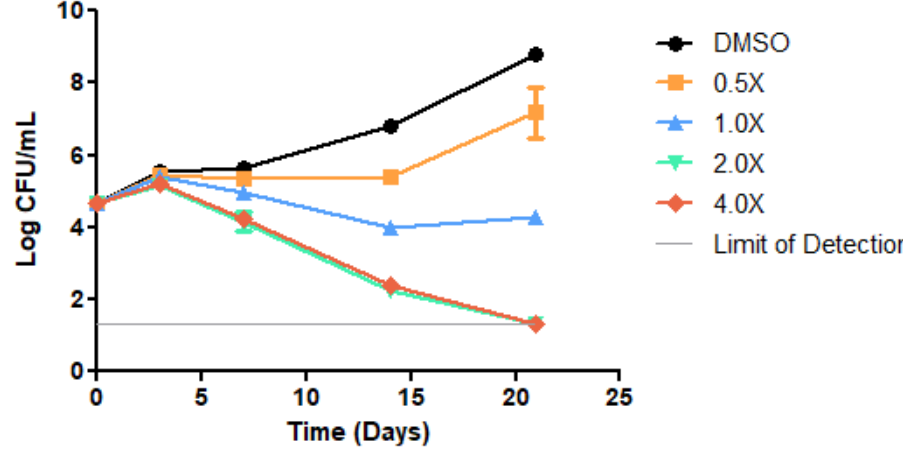
Figure 2. Time-kill curves of compound 3r against replicating Mycobacterium tuberculosis H37Rv. Kill kinetics were determined under standard aerobic conditions. Viability was monitored by determining CFU/mL. The lower limit of detection was 200 CFU/mL for undiluted samples on plates. Data represent the mean ± standard deviation of biological triplicate measurements.